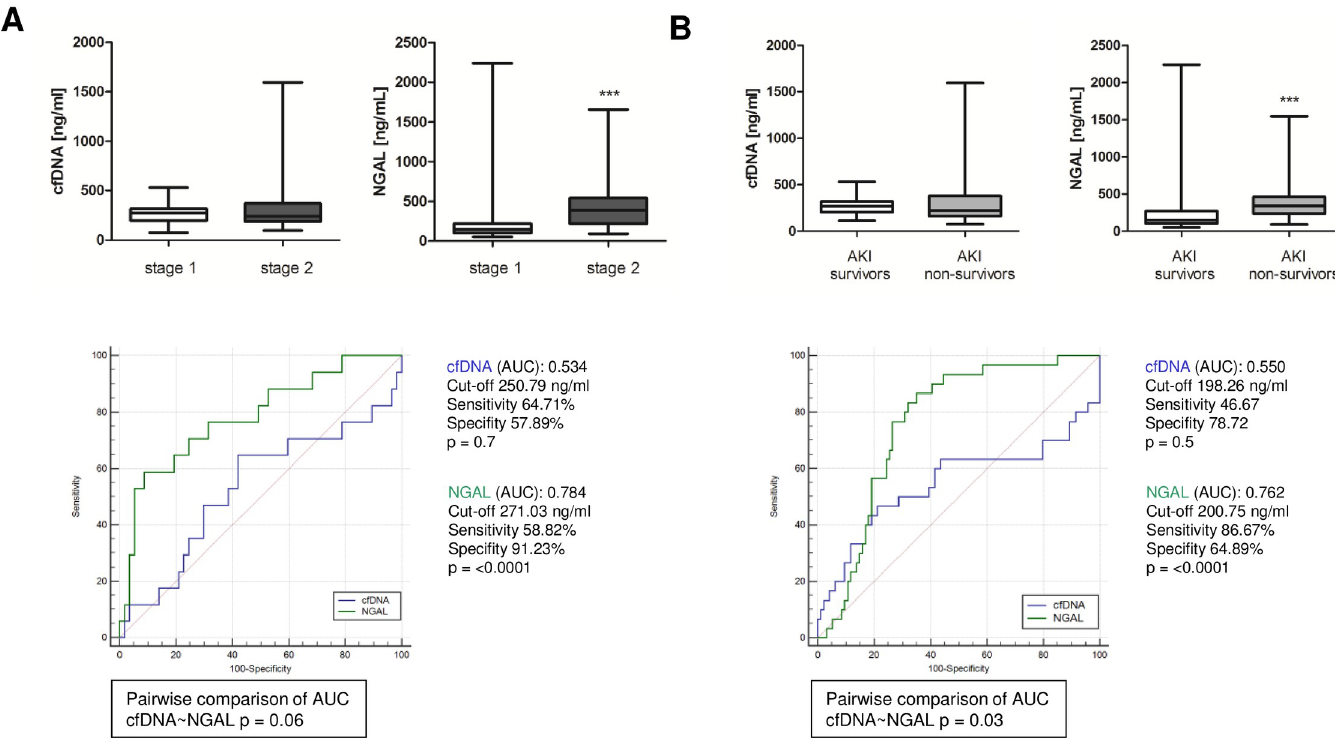
Fig 4. Association of disease severity and mortality with cfDNA and NGAL. (A) cfDNA and NGAL were compared between patients with stage 1 (n = 14) and stage 2 (n = 7) AKI. Receiver operating characteristic curves were performed for the prediction of tsgae 2 AKI. (B) cfDNA and NGAL levels in patients in survivors and patients who died during 1-year follow-up. Receiver operating characteristic curves were performed for the prediction of mortality in AKI patients.